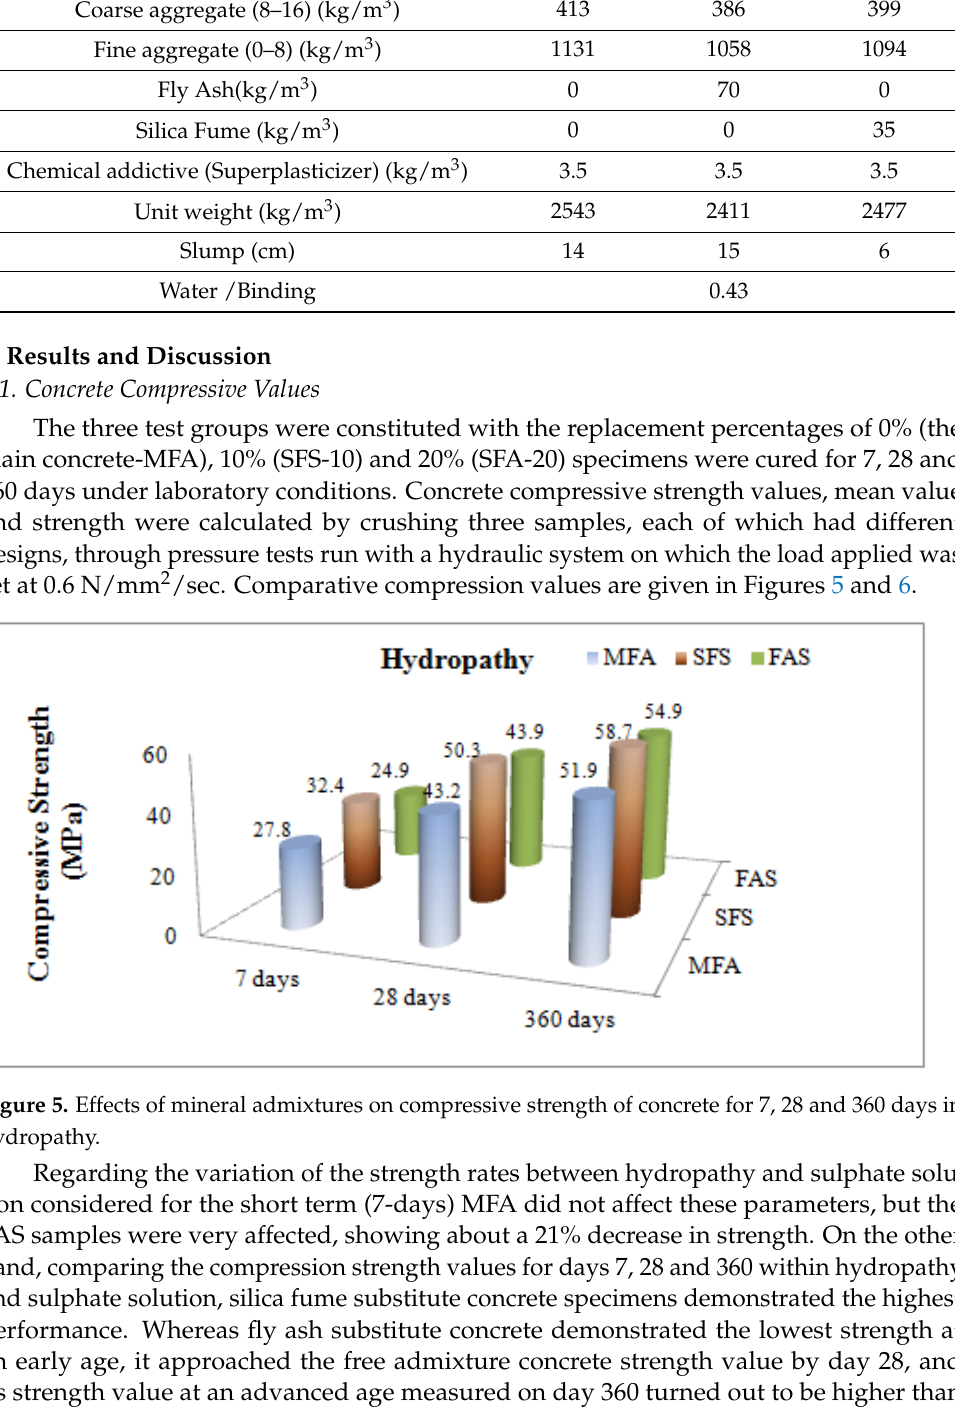
Figure 6. Effects of mineral admixtures on compressive strength of concrete for day 7, 28 and 360 exposed to sulphate solution. Regarding the variation of the strength rates between hydropathy and sulphate so- lution considered for the short term (7-days) MFA did not affect these parameters, but the FAS samples were very affected, showing about a 21% decrease in strength. On the other hand, comparing the compression strength values for days 7, 28 and 360 within hydropa- thy and sulphate solution, silica fume substitute concrete specimens demonstrated the highest performance. Whereas fly ash substitute concrete demonstrated the lowest strength at an early age, it approached the free admixture concrete strength value by day 28, and its strength value at an advanced age measured on day 360 turned out to be higher than that of a admixture-free concrete. The change in compression strength values of con- crete samples soaked in hydropathy and sulphate solution on day 360 and day 28 are given in percentages in Figure 7.